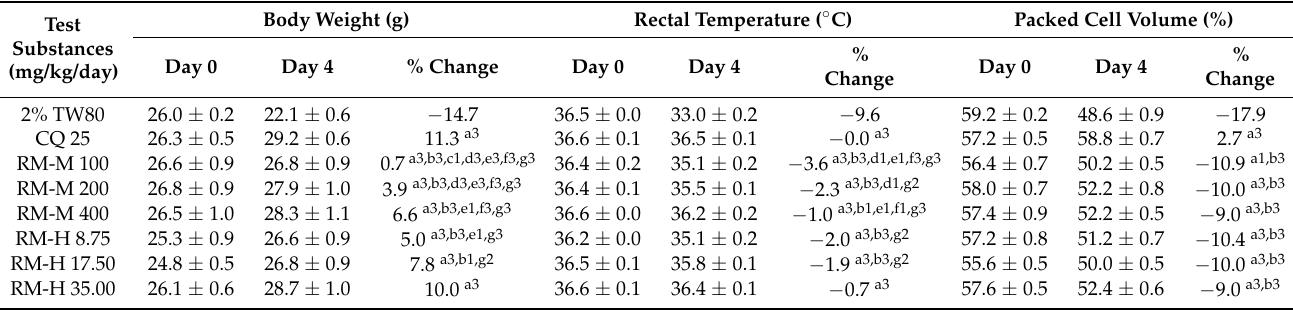
Table 2. Effect of leaf extracts of Ranunculus multifidus on body weight, rectal temperature and packed cell volume of Plasmodium berghei -infected mice in 4-day suppressive